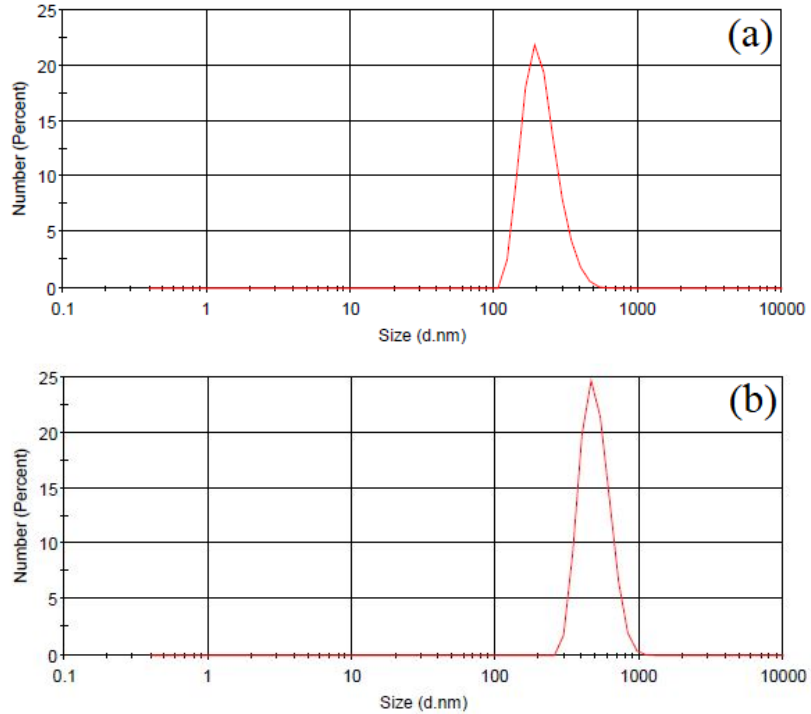
Figure 1. Particle size distribution of submicron Y 2 O 3 powder in the slurry electrolyte before ( a ) and after ( b ) PEO treatment for 60 min.